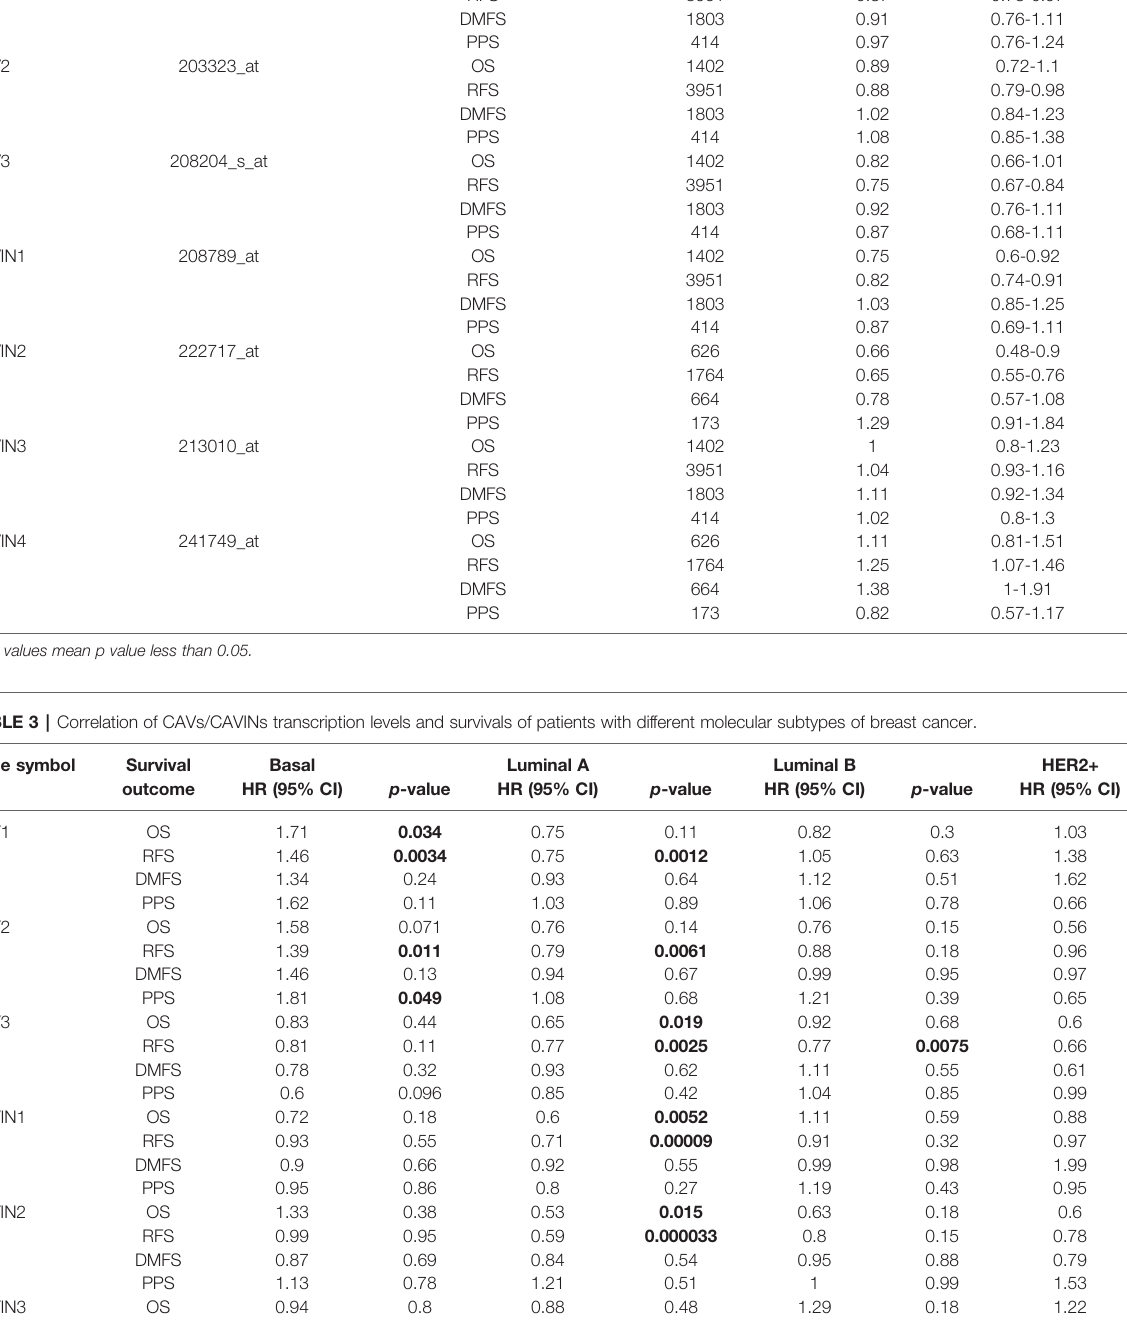
TABLE 2 | Correlation of CAVs/CAVINs transcription levels and survivals of patients with breast cancer. Gene Dataset/ Affymetrix ID Survival outcome